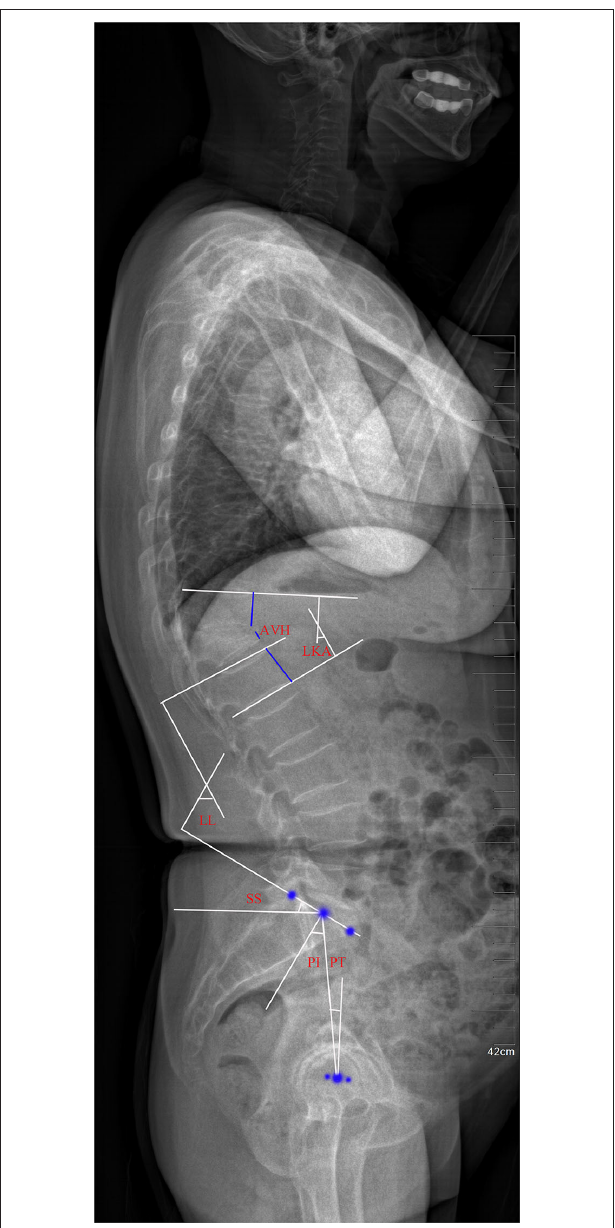
FIGURE 3 | Plain lateral radiograph for measuring radiographic parameters. AVH, anterior vertebral height; LKA, local kyphotic angle; LL, lumbar lordosis; SS, sacral slope; PI, pelvic incidence; PT, pelvic tilt.